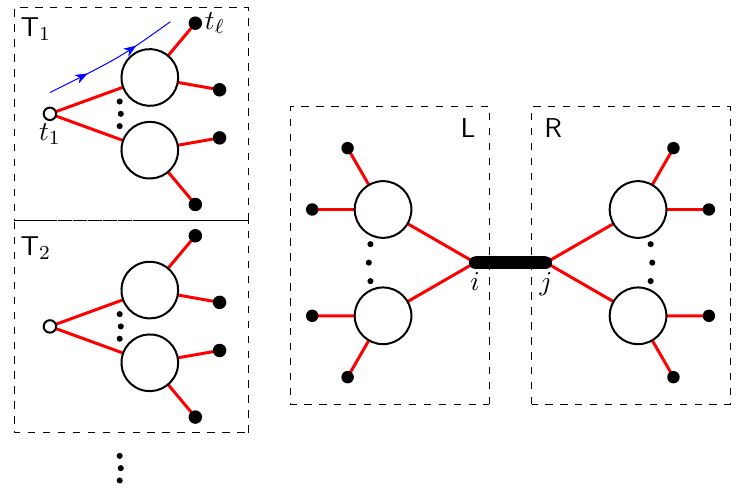
Figure 3 . The graph for general disconnected